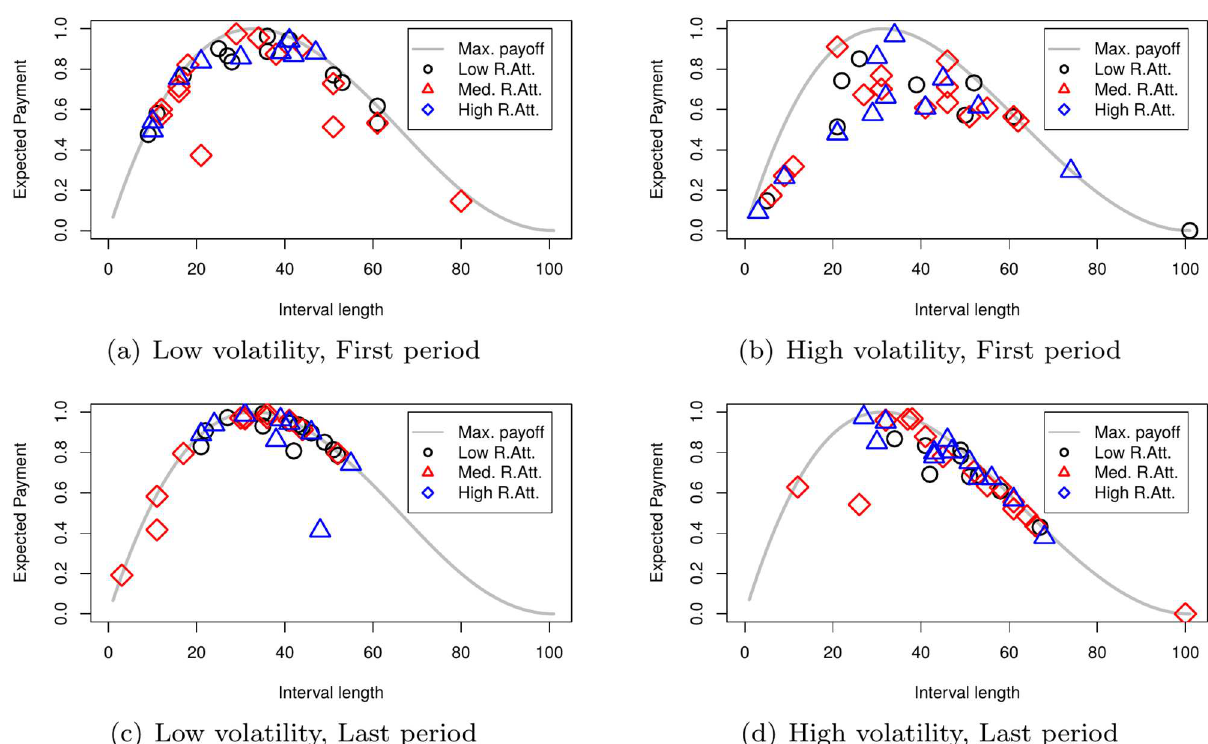
Fig 6. Individual performance against interval length for the two treatmentsin the first and last